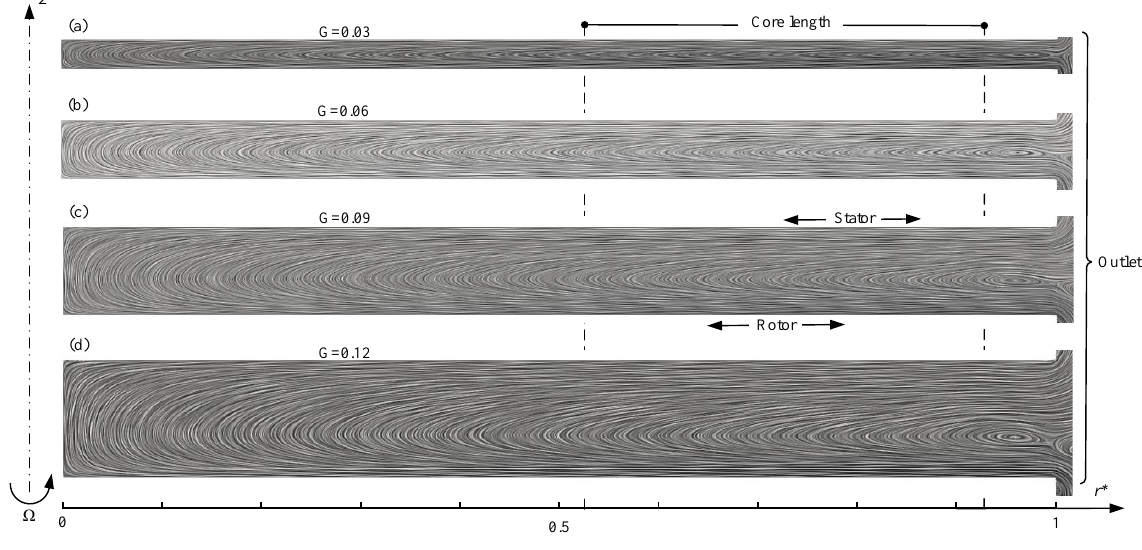
Figure 16. Line Integral Convolution (LIC) representation of the flow structure inside the AFPM machine for a fixed Reynolds number Re = 5513 without an air-inlet. ( a – d ) correspond to different gap-length ratios G. Use is made of two dimensionless length scales, z ∗ = z / d and r ∗ = r / R , where d is the gap-length and R the outer